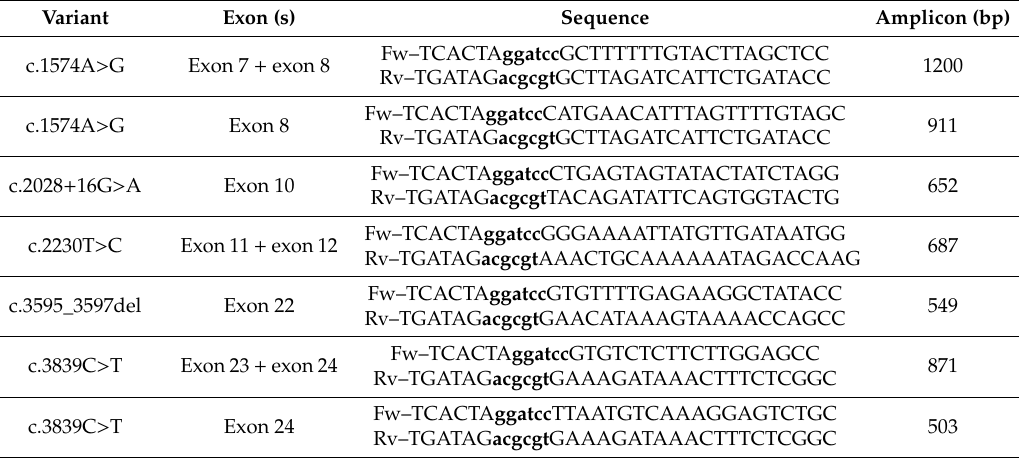
Table 6. Primers used to amplify the inserts used in the minigene assays